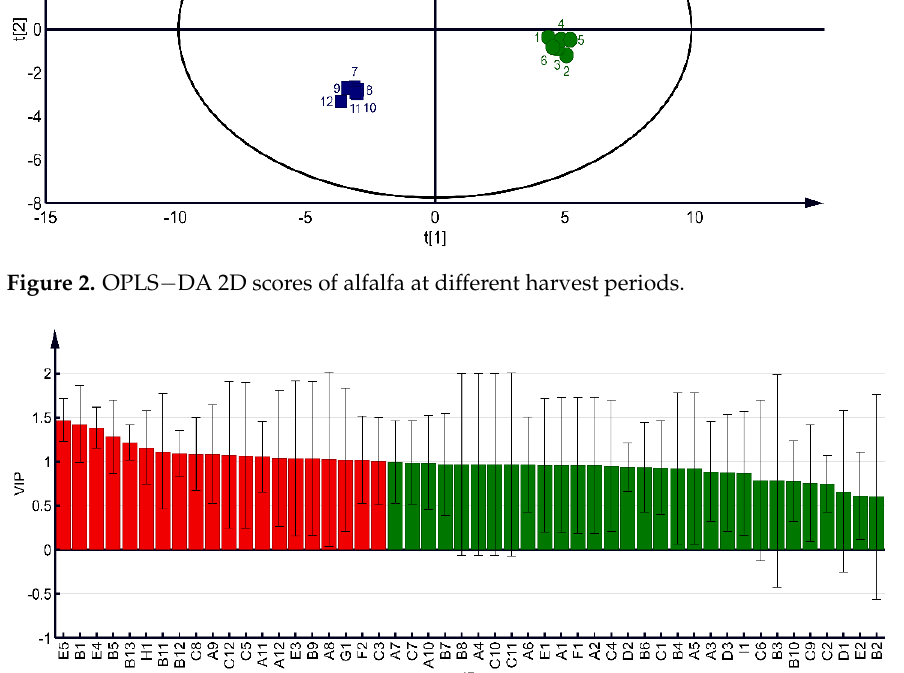
Figure 3. VIP map of VOCs in alfalfa at different harvest periods.